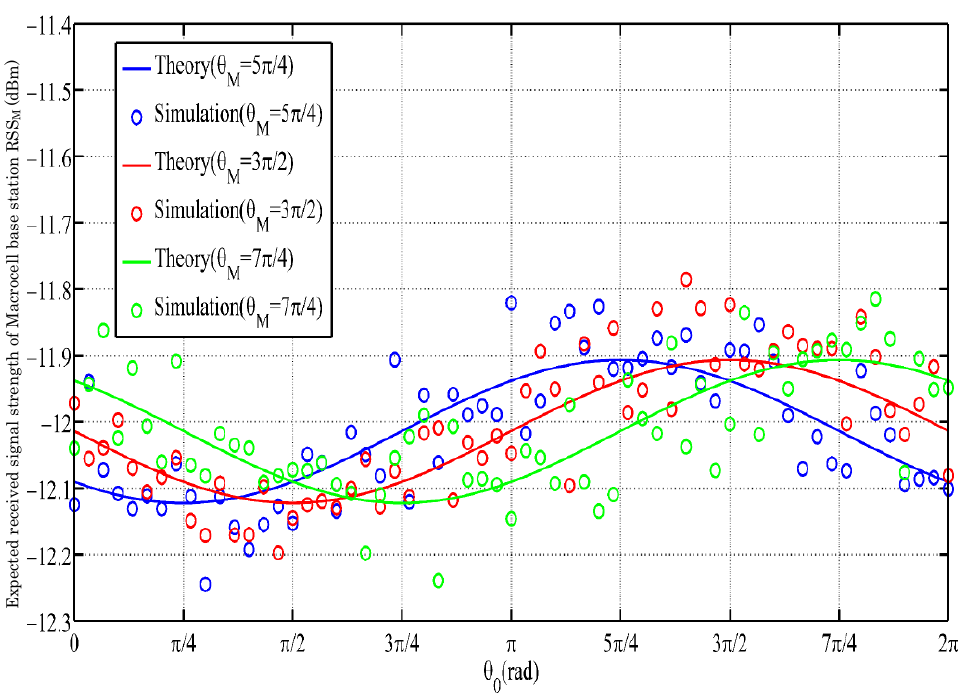
Figure 13. When r = 30 m/s, expected received signal strength of macrocell base station RSS M